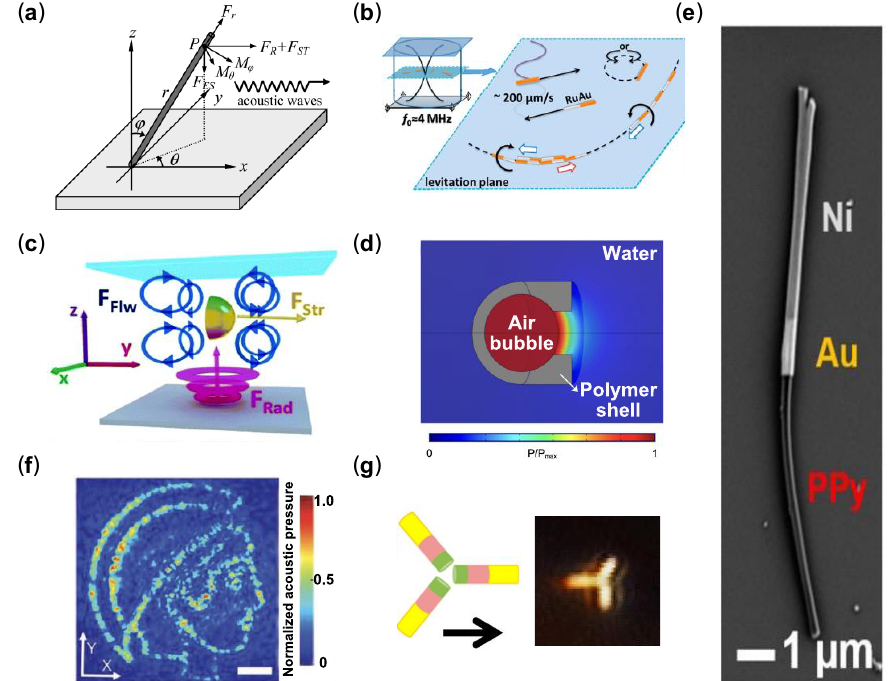
Figure 4. Schematic diagram of acoustic field drive method. ( a ) A nanotube connected to the surface of the substrate at one end, with pressures and torques applied to it by the incoming sonic wave and electrostatic contact [127] (Reproduced with permission from Lim et al., The Journal of Chemical Physics; published by AIP Publishing, 2007); ( b ) Schematic diagram of the trajectory and velocity of the nanorods [46] (Reproduced with permission from Wang et al., ACS Nano; published by American Chemical Society, 2012); ( c ) Nanoshells’ motion under the effect of ambient fluid flow(F Flw )and acoustic radiation forces (F Rad ) [47] (Reproduced with permission from Soto et al., Nanoscale; published by Royal Society of Chemistry, 2016); ( d ) Simulated acoustic pressure diagram of a microrobot in a fluid medium [50] (Reproduced with permission from Aghakhani et al., Proceedings of the National Academy of Sciences; published by National Academy of Sciences, 2020); ( e ) Image of a nanoswimmer under scanning electron microscope [51] (Reproduced with permission from Ahmed et al., Nano letters; published by American Chemical Society, 2016); ( f ) The sound pressure field measured in the image plane [130] (Reproduced with permission from Melde et al., Advanced Materials; published by Wiley, 2020); ( g ) Shape of acoustic nanoparticle distribution Octahedral hexamer-shaped nanorods formed by the ultrasonic field [131] (Reproduced with permission from Ahmed et al., ACS Nano; published by American Chemical Society,